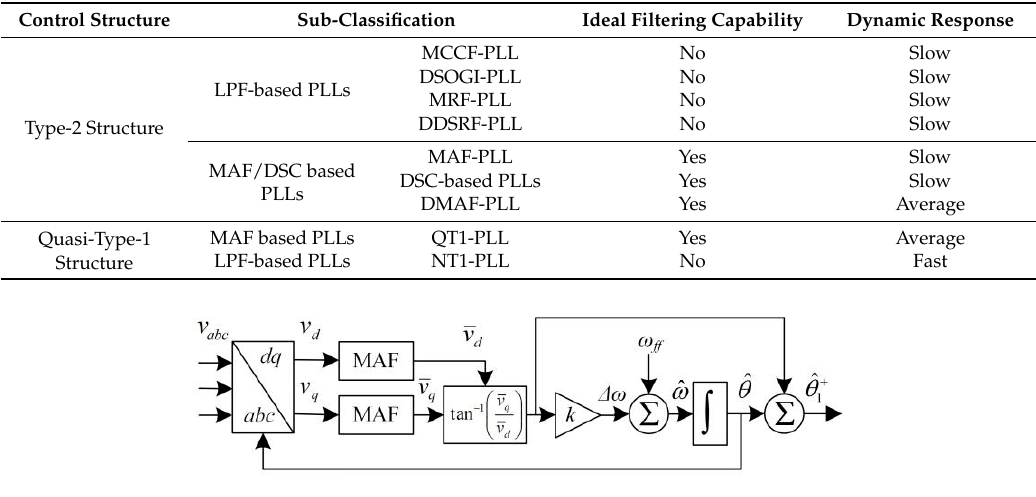
Figure 3. Block scheme of QT1-PLL.